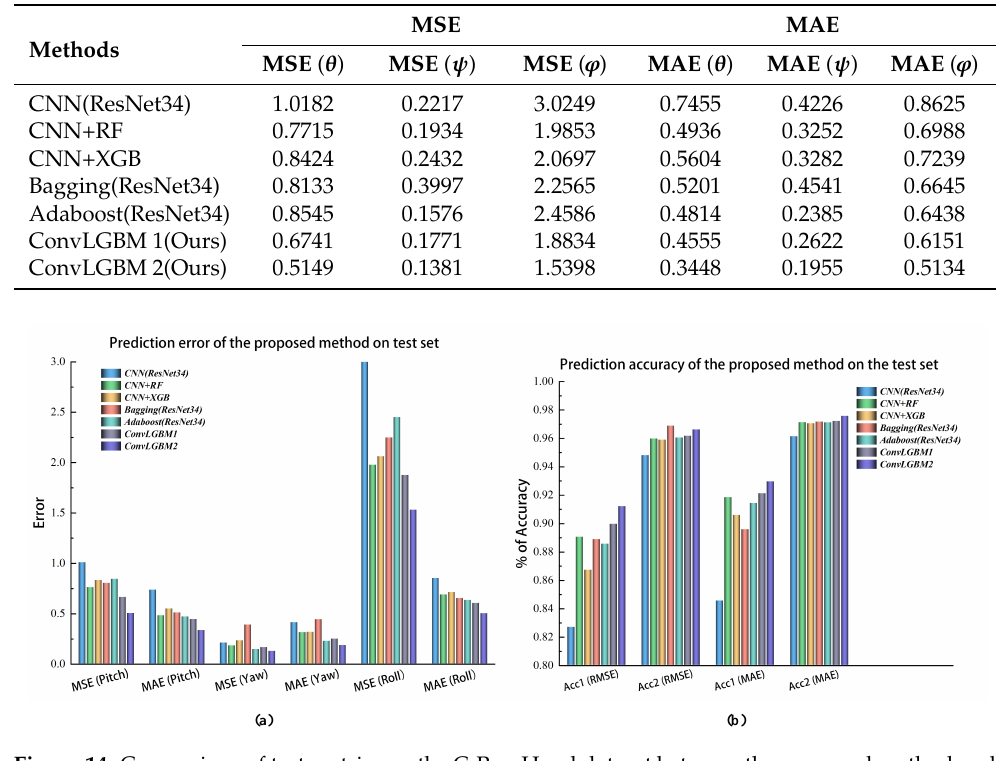
Figure 14. Comparison of test metrics on the C-PoseHand dataset between the proposed method and other methods. ( a ) Comparison of the prediction error. ( b ) Comparison of the prediction accuracy. Table 6. Comparison of accuracy between the proposed method and other methods.